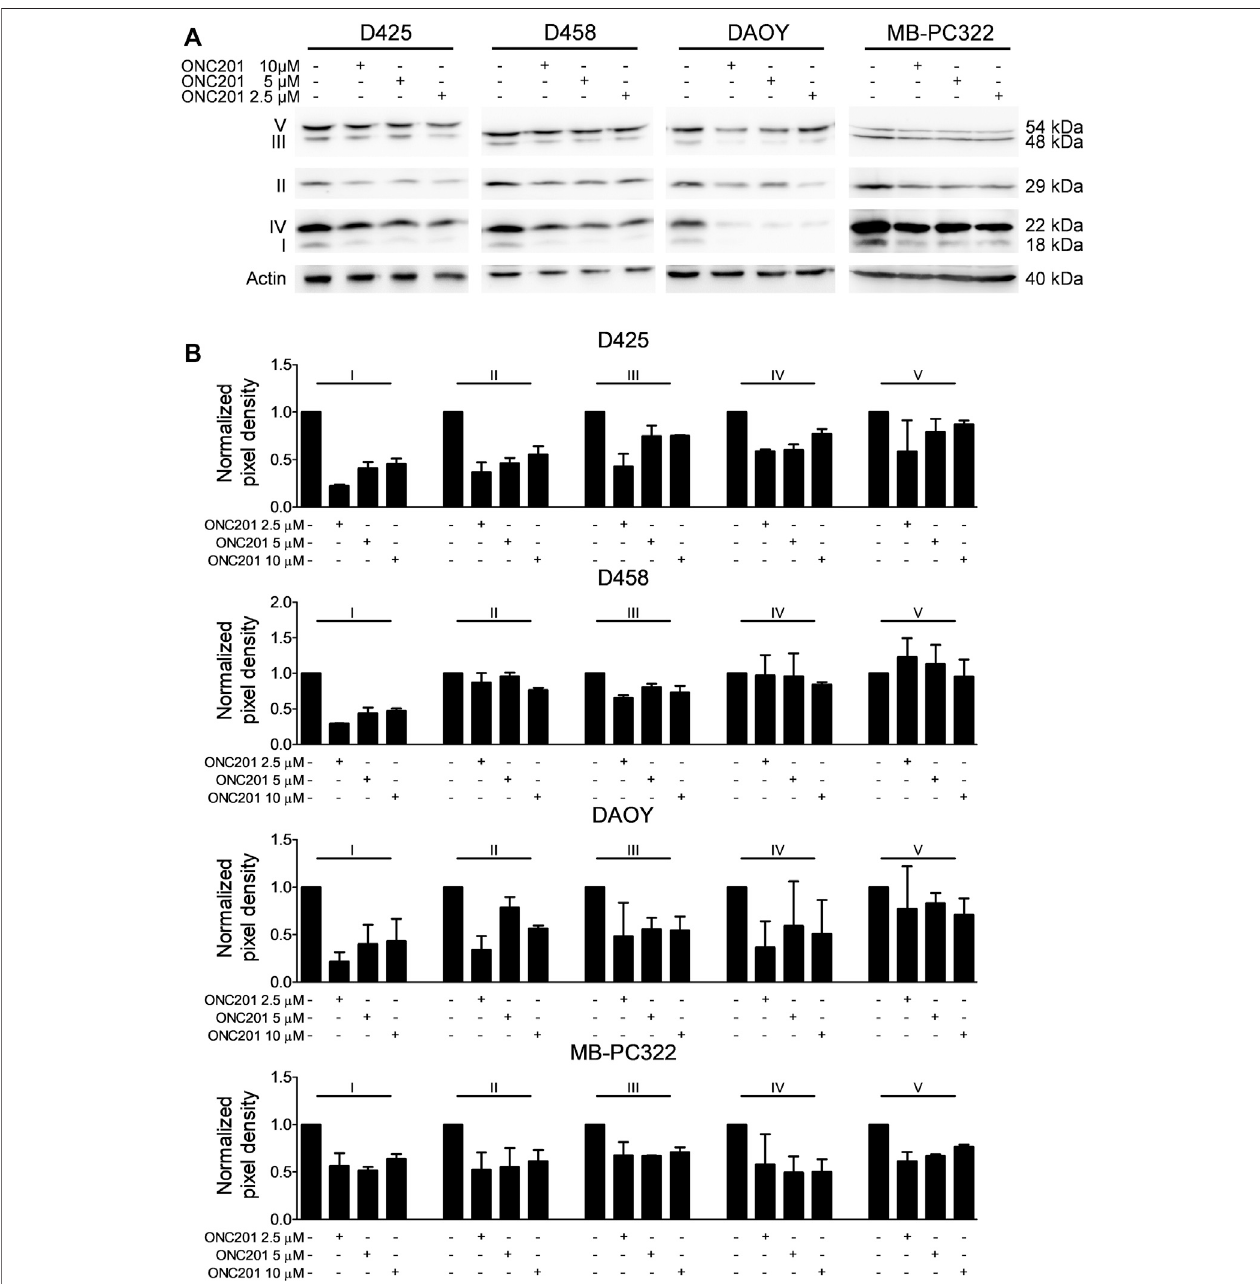
FIGURE 3 | ONC201/TIC10 reduces the expression of respiratory chain complexes. (A) , D425, D458, DAOY and MB-PC322 cells were treated for 24 h as indicated. Cell lysates were collected and analysed by Western blot for the expression of respiratory chain complexes I-V. Equal loading was con fi rmed by analysis for Actin expression. (B) , Quantitative representation of cells treated as described for A. Densitometric analysis was performed using ImageJ (NIH, Bethesda, MD; http:// imagej.nih.gov/ij). Data were normalized to control. Columns: mean. Error bars: SD. N (cid:1) 2.